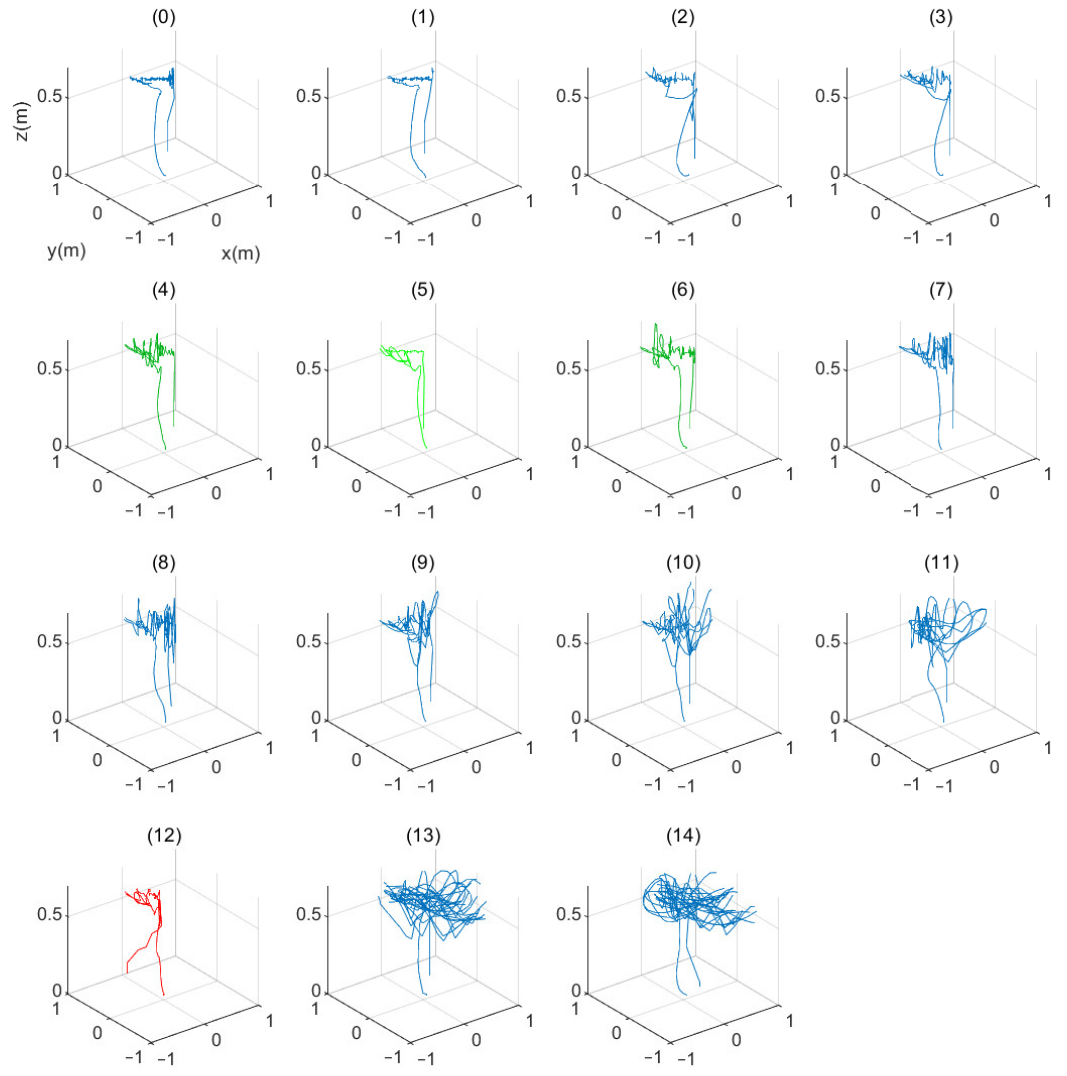
Figure 14. Different tests made using buffer sizes from 0 to